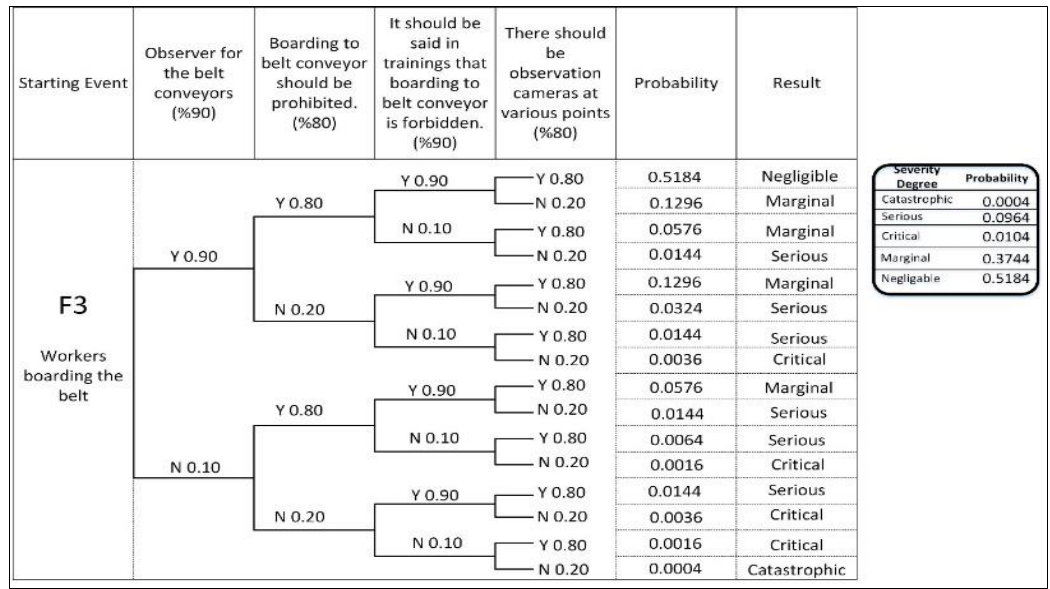
Figure 7: Event tree analysis diagram of F3.